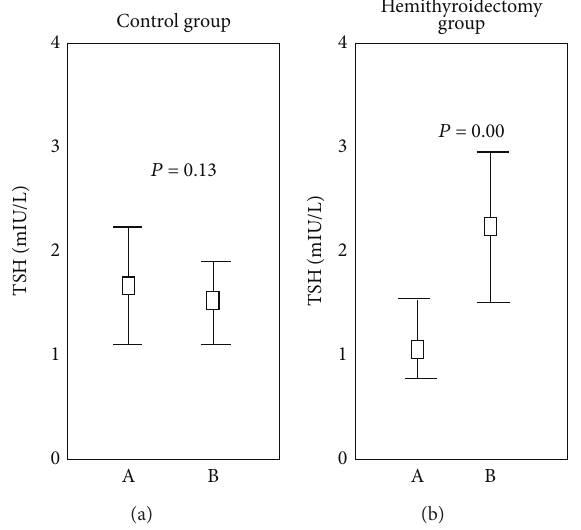
Figure 2: Weight changes between baseline and follow-up. Weight changes of the hemithyroidectomy group ( 𝑛 = 28 ) and of the control group ( 𝑛 = 47 ). The median, upper, and lower quartiles are presented. Outliers are excluded. The Wilcoxon signed-rank test was used. Statistical significance was demonstrated whenever 𝑃 < 0.05 .